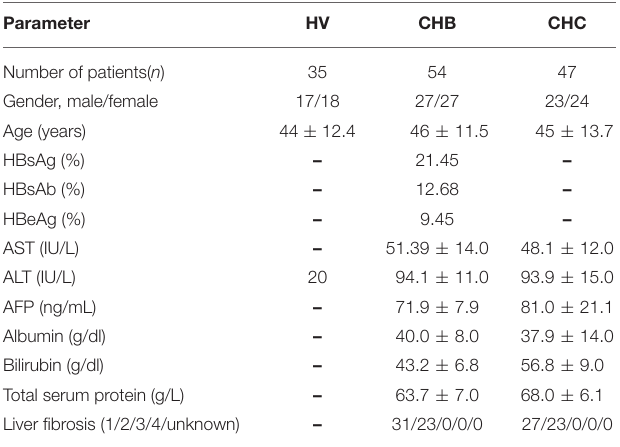
TABLE 1 | Characteristics of health volunteers and the patients of CHB and